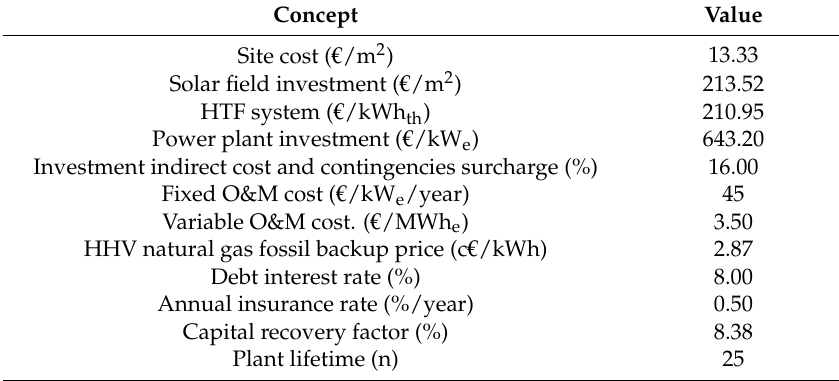
Table 5. Main data for PT solar thermal power plant levelized cost of electricity (LCOE)